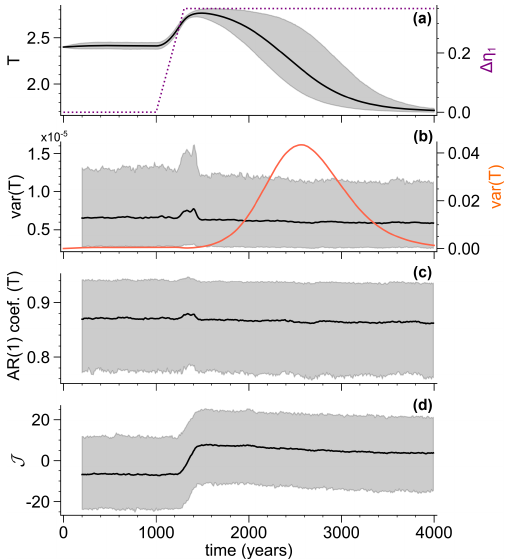
Figure 16. Early warning indicators estimated in a 200-year sliding window from an ensemble of time series of the Stommel model, where η 1 is ramped from η 1 = 2 . 65 to η 1 = 3 . 0 within 300 years. (a) Time series of T and the parameter ramp. (b) Variance estimated from the detrended time series, as well as the ensemble variance (orange). (c) Lag 1 autocorrelation in the sliding window. (d) Early warning indicator J (Eq. A6) estimated from the Jacobian in the sliding window. Mean time series are shown in black and the range in between 5th and 95th percentiles are shaded in